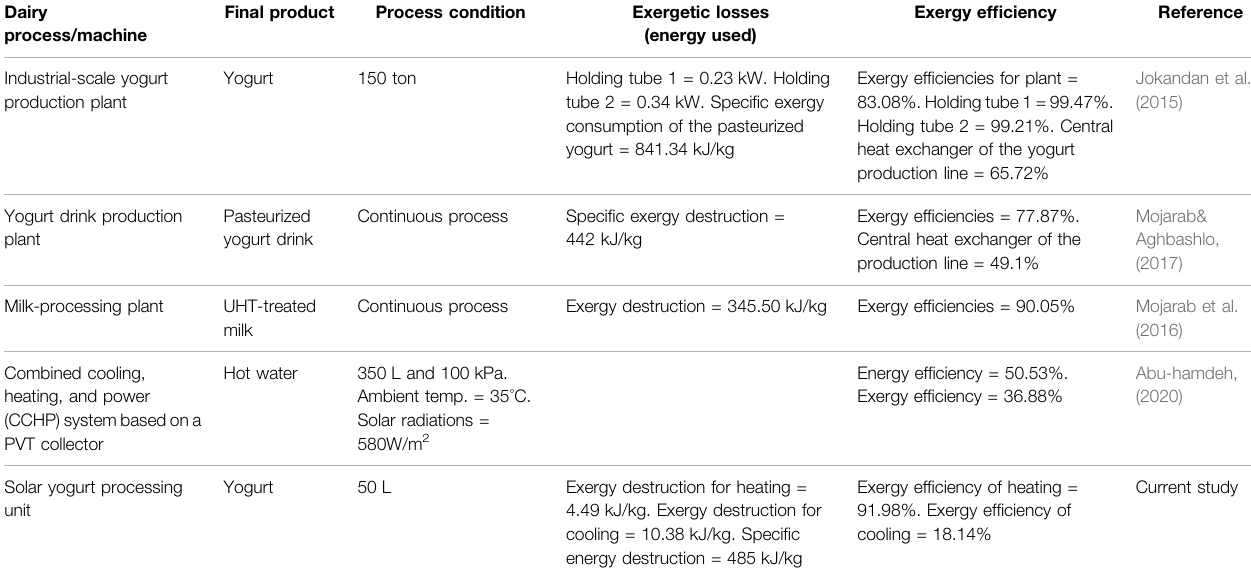
TABLE 3 | Comparison of thermal analysis conducted for the performance evaluation of different dairy product processes and